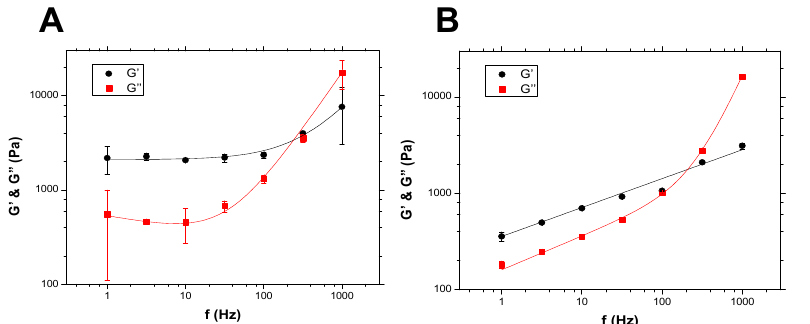
Figure 3. ( A ) Viscoelastic properties ( G (cid:48) , G (cid:48)(cid:48) ) of a T24 spheroid with no collagen . D ∼ 320 µ m. Initial number of cells = 10,000. The lines correspond to the model in Equation (3), using G 0 = 2100 Pa, a = 0, G 1 = 4.8 Pa, b = 1.02, G 2 = 530 Pa, c = − 0.15, G 3 = 4.4 Pa, d = 1.2. ( B ) Viscoelastic properties ( G (cid:48) , G (cid:48)(cid:48) ) of a T24 spheroid containing collagen at 0.03 mg/mL. D ∼ 410 µ m. Initial number of cells=10,000. The same model gives G 0 = 358 Pa, a = 0.30, G 1 = 0 Pa, b = 0, G 2 = 161 Pa, c = 0.35, G 3 = 0.026 Pa, d = 1.92. Representative data are shown here with N = 2 (no collagen) and N = 4 (0.03 mg/mL); error bars represent the mean ±